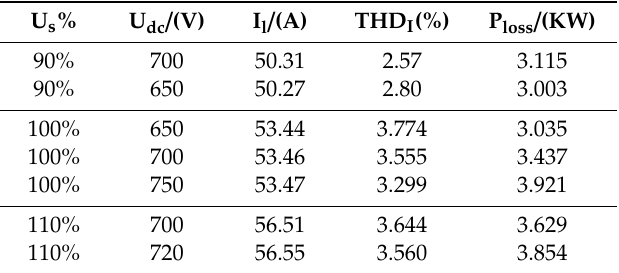
Table 2. Analysis of compensation performance and power losses on